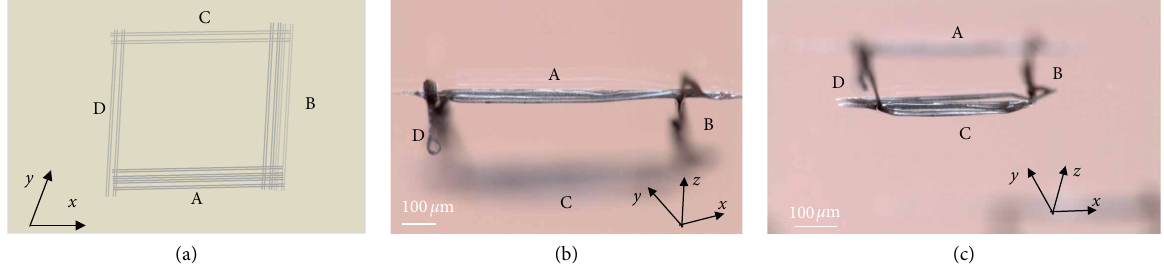
A where is possible to reconstruct out of focus the